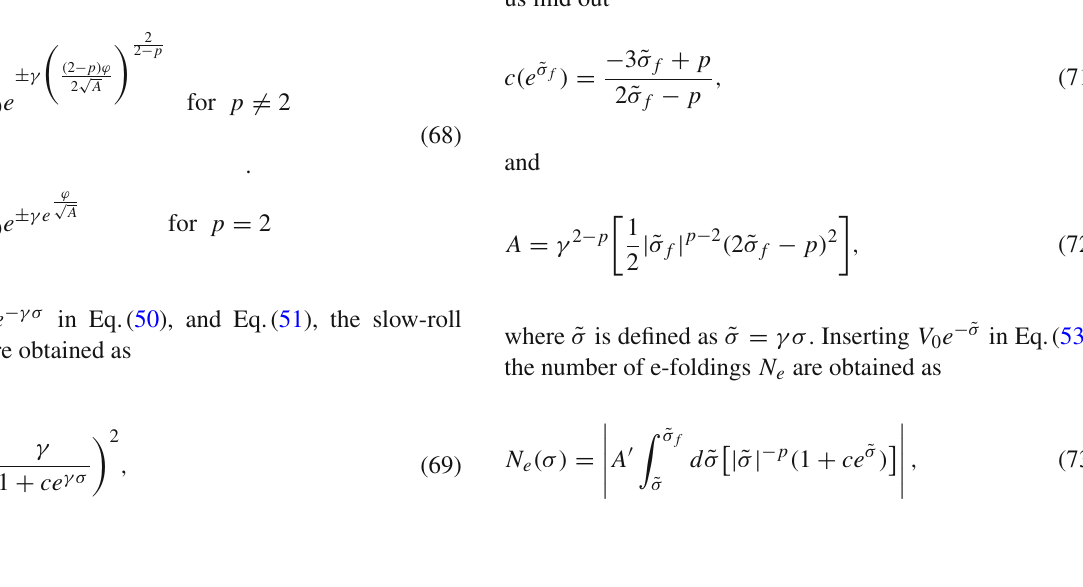
Fig. 2 Plots of r ( n s ) and N e ( n s ) for the exponential potential V 0 e −˜ σ , p > 0 and c = 0 (top plots) and c = 0 . 5 (bottom plots). In left plots, green and blue regions are related to the Planck 2018 data [33] and its combination with BK18 and BAO [34], respectively. In addition, the 68% confidence regions are highlighted compared to the 95% confi- dence regions. Depending on the values of p , the curves of r ( n s ) for